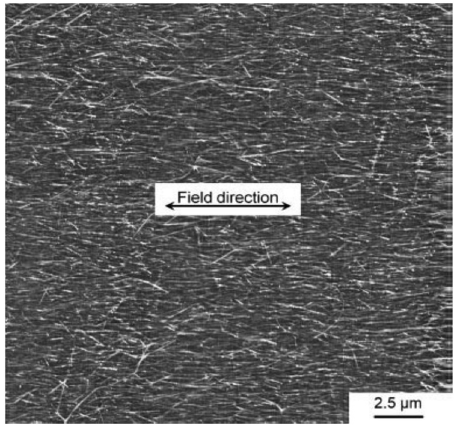
Figure 10: AFM image of electric fi eld - oriented CNC fi lms. Adapted from ref. [ 64 ] .